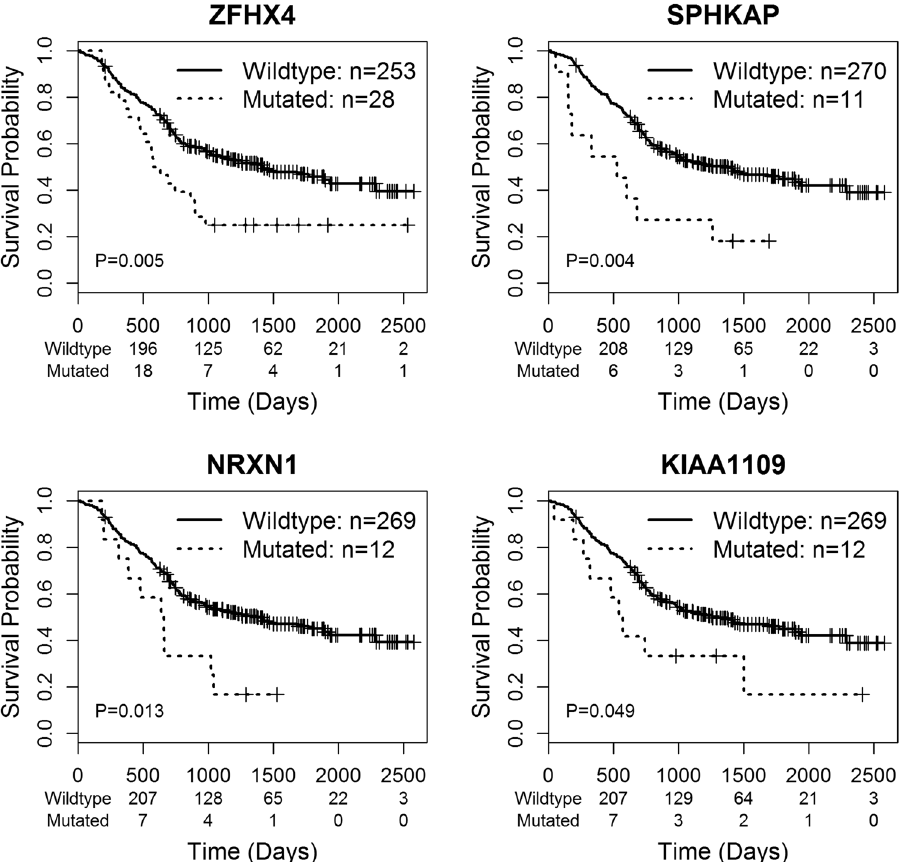
Figure 2. Survival analysis for mutations of frequently mutated genes. The overall survival rates of patients according to gene mutation status were shown. Wildtype indicates a group of patients without gene mutation. Mutated means that patients carry gene mutation. P values were calculated by the log-rank